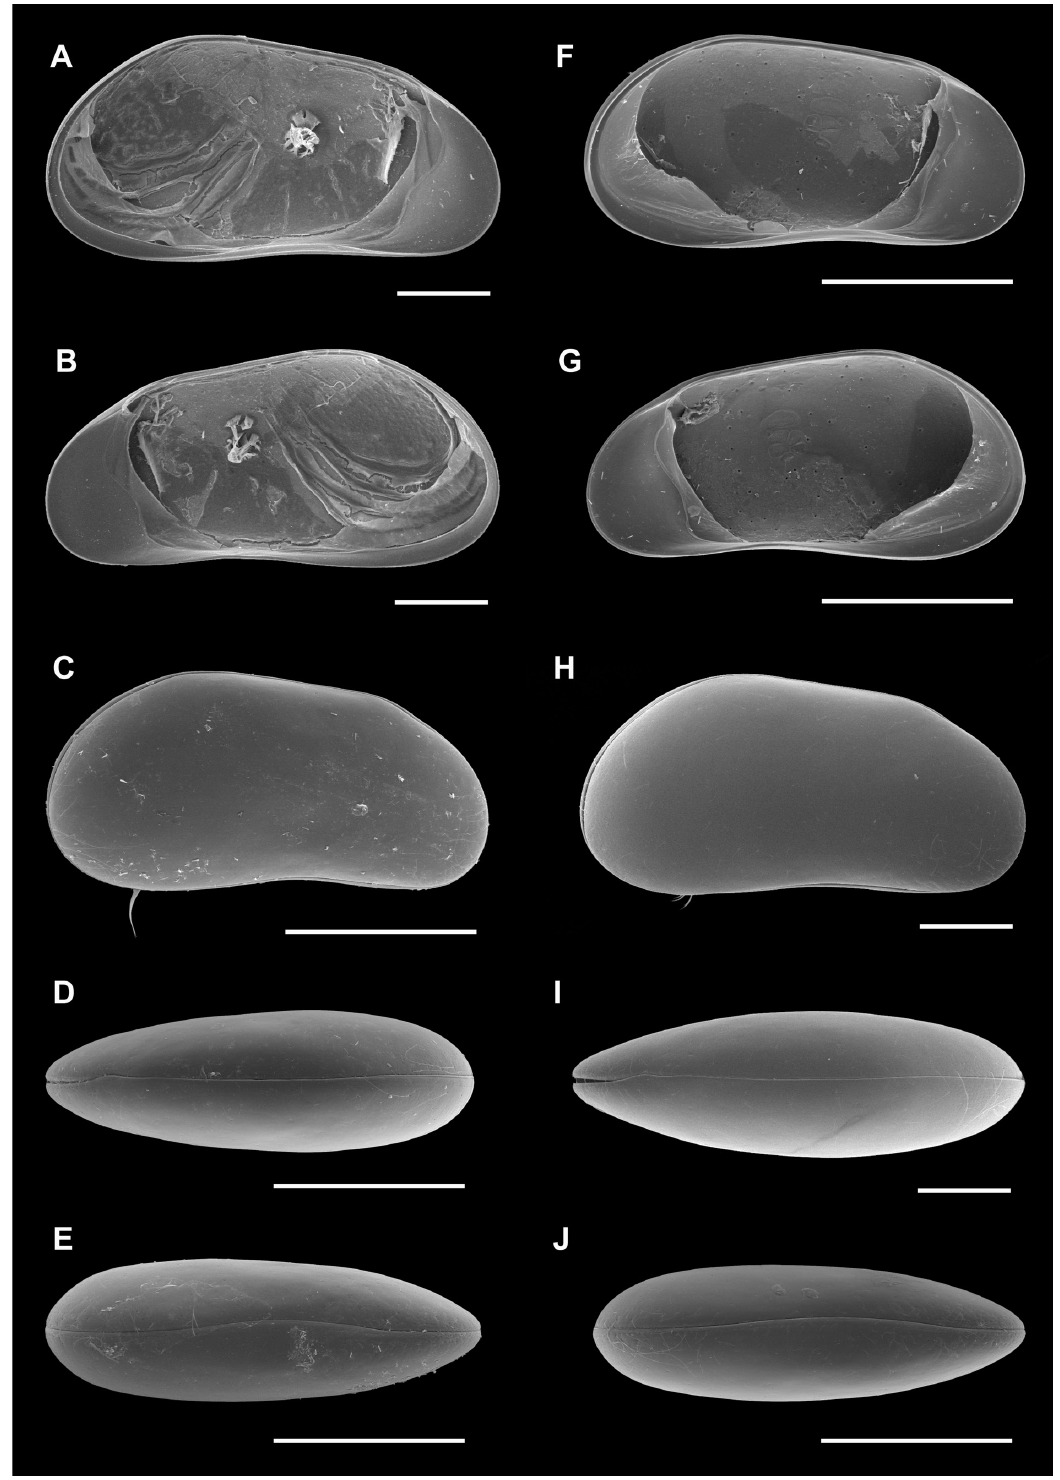
Fig. 8. Candobrasilopsis brasiliensis (Sars, 1901) comb. nov., valves (A-E ♂, F-J ♀). A, F . LV, internal view (A: MZUSP.28118, F: MZUSP.28125). B, G . RV, internal view (B: MZUSP.28118, G: MZUSP.28125). C, H . Cp, right lateral view (C: MZUSP.28119, H: MZUSP.28126). D, I . Cp, dorsal view (D: OC.3297, I: OC.3301). E, J . Cp, ventral view. (E: OC.3298, J: MZUSP.28127). Scale bars: A, B, H, I = 200 µm; C-G, J = 400